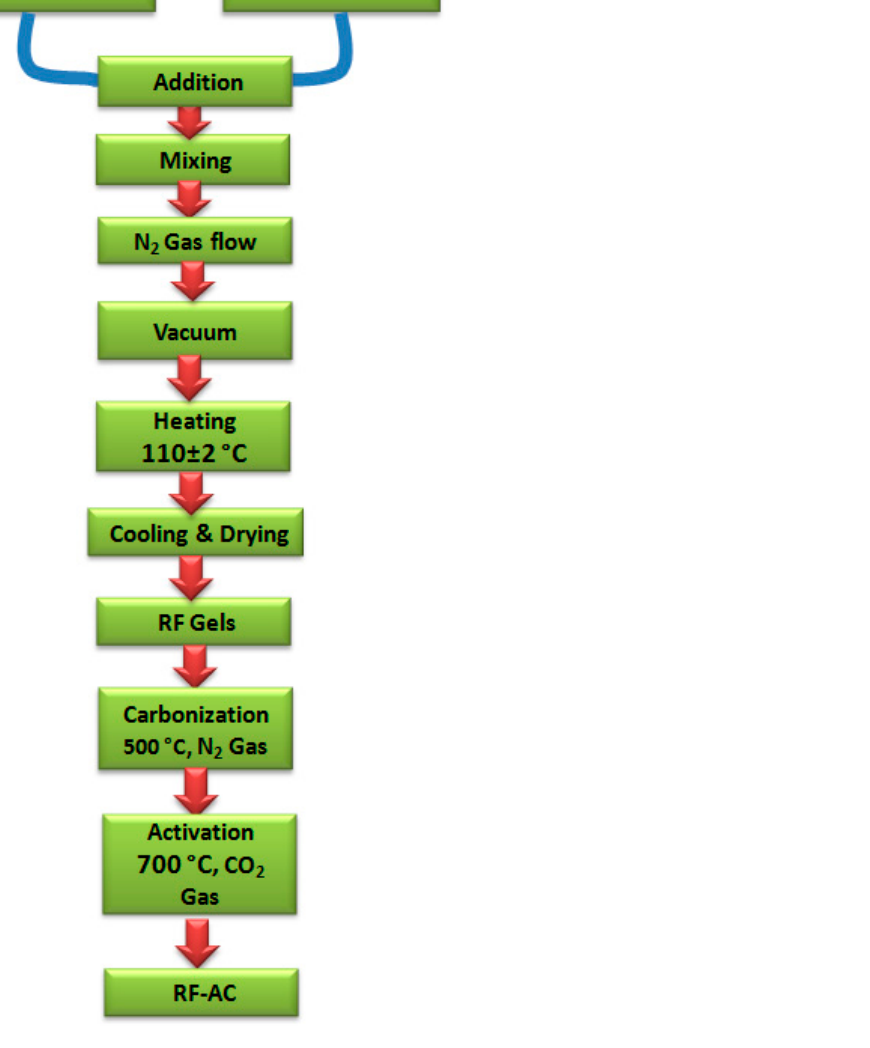
Figure 1. Graphical presentation of preparation methods for RF gels and activated carbons.